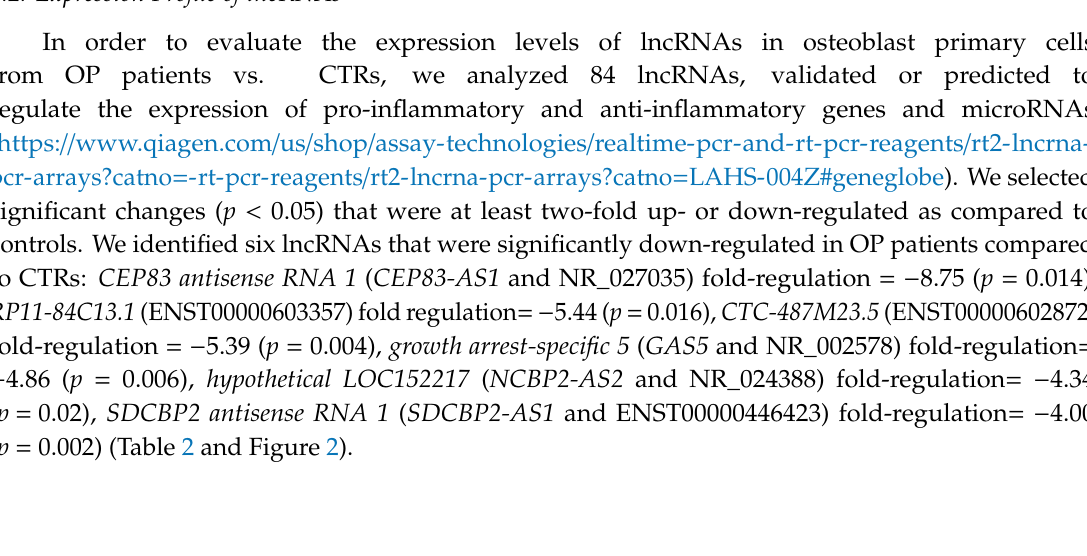
Table 2. Differentially-expressed long non-coding RNAs in OP patients vs. CTRs.